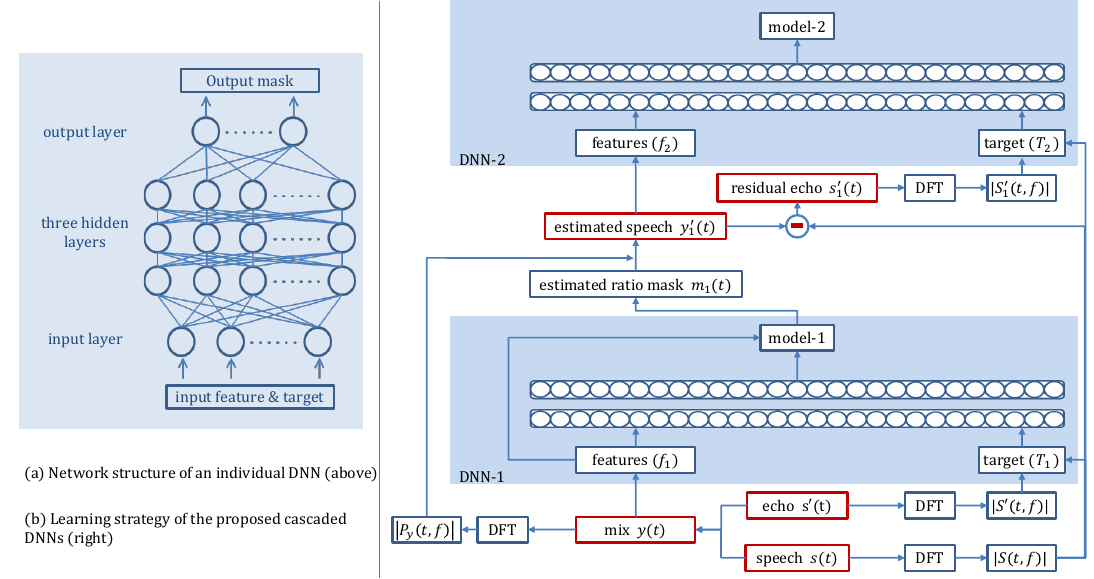
Figure 3. Network architecture and learning strategy of the proposed